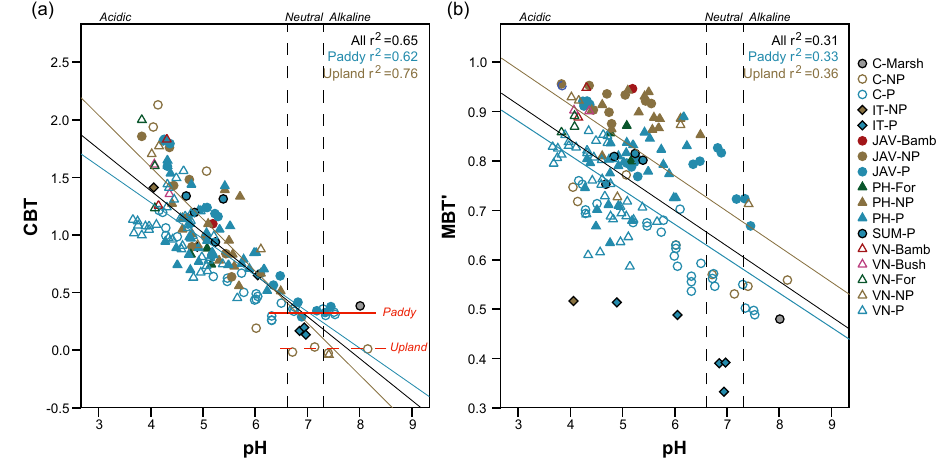
Figure 6. Plot of (a) the cyclization ratio of branched tetraethers (CBT) vs. soil pH and of (b) the modified methylation index of branched tetraethers (MBT (cid:48) ) vs. soil pH. Dashed lines indicate neutral soil conditions, which delimitate the interval between 6.6 and 7.3 pH units. Regressions line of all soils is black, the line of upland, marsh, forest, bamboo and bushland soils is brown and the line for paddy soils is blue. Abbreviations as in Fig. 2. Red lines in (a) show the offset between paddy and upland soil, which have >6.2 pH